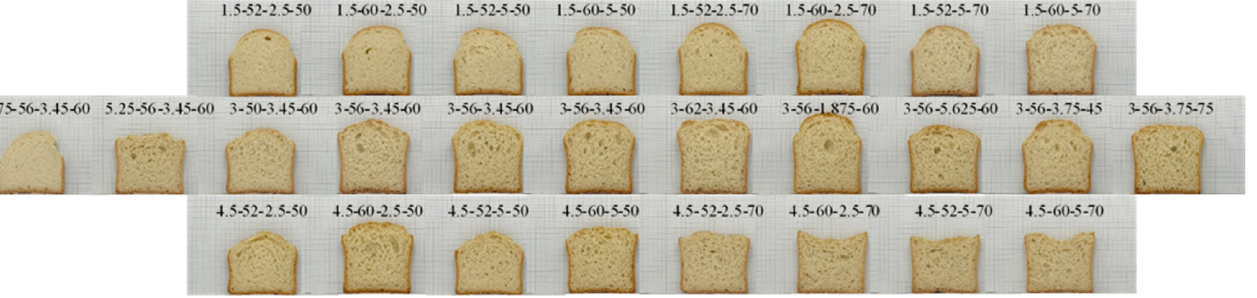
Table 4. Fermented dough height and height, volume, and firmness of bread prepared with ‘O ‐ free’ flour.